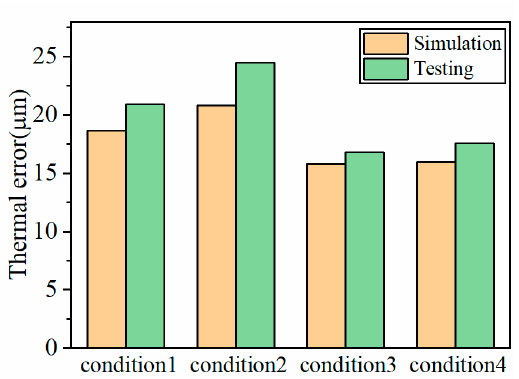
Figure 18. Comparison of thermal error simulation results and thermal error experimental results.